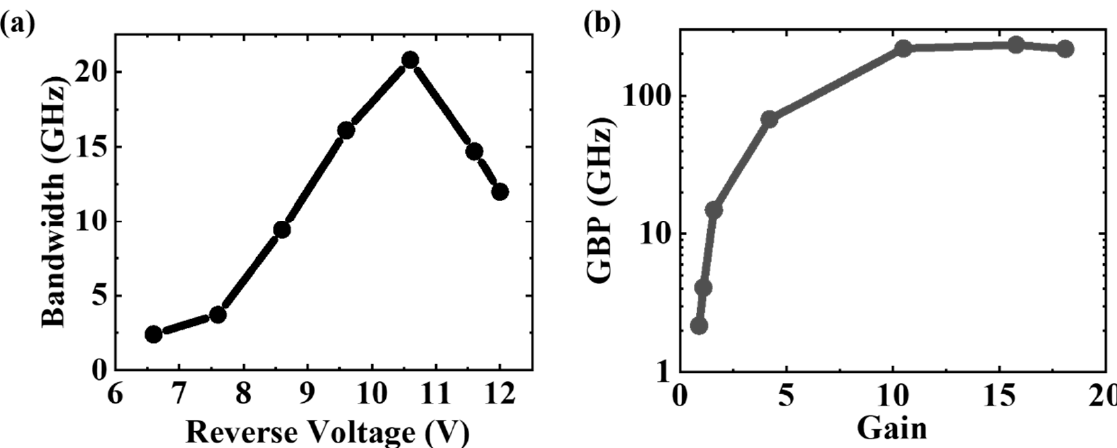
Figure 9. ( a ) The extracted 3-dB bandwidth is the function of the reverse voltage; ( b ) the extracted gain-bandwidth product is the function of the reverse voltage.